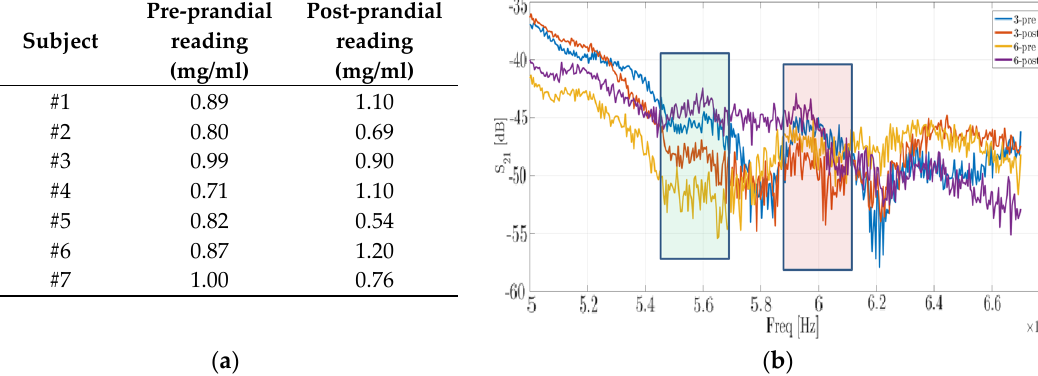
Figure 3. Comparative analysis for the clinical blood samples using PNA and glucometer: ( a ) Glucometer readings for the seven participants pre and post glucose consumption; ( b ) PNA measurements of the transmission coefficients for pre and post blood samples of two patients. Shaded windows show the frequency regions where both the PNA and glucometer patterns are consistent.